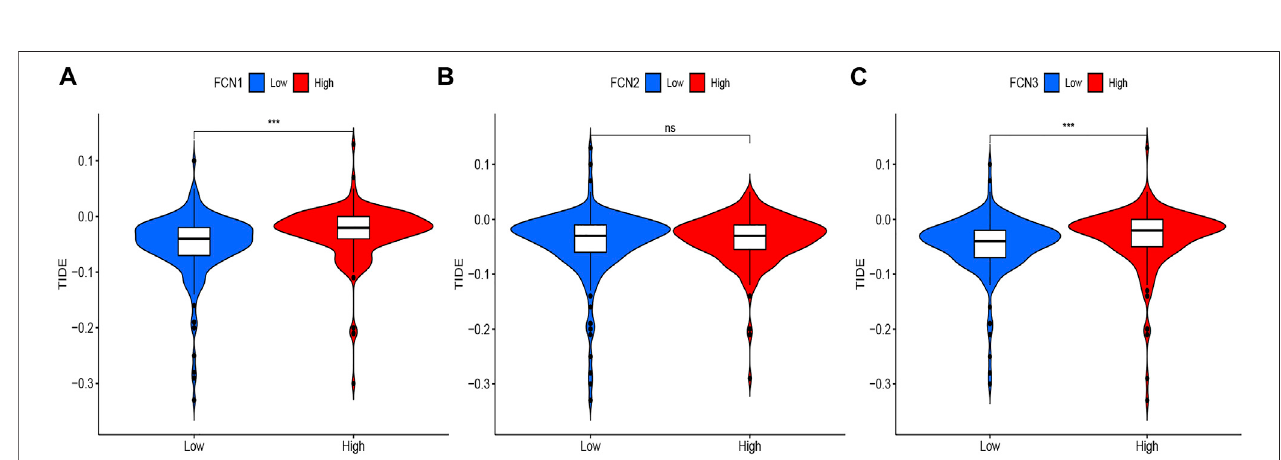
FIGURE 11 | Correlation between FCNs expression and TIDE score. (A) FCN1; (B) FCN2; (C) FCN3; *** p < 0.001.